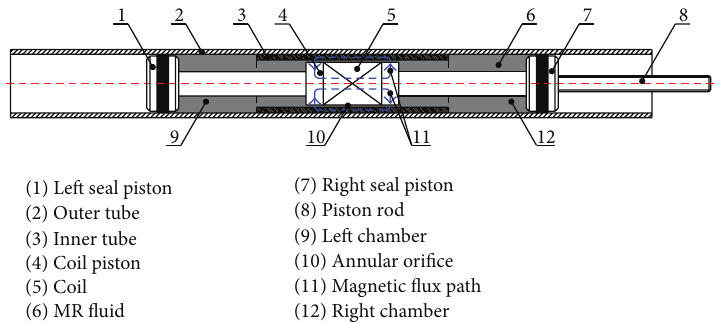
Figure 5: Schematic configuration of the double-piston MR